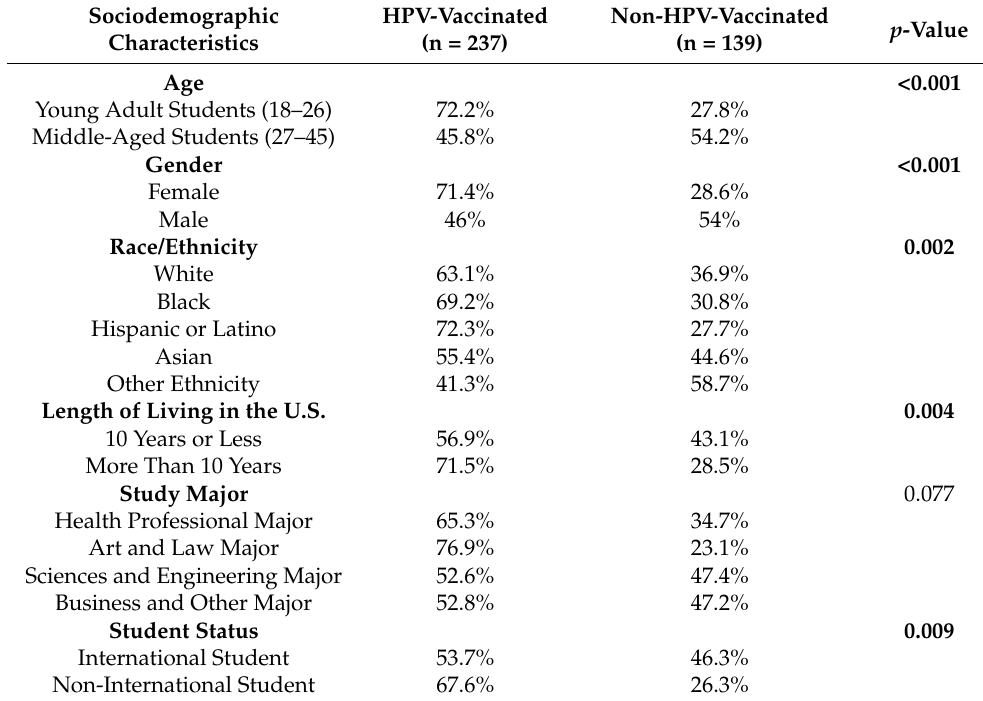
Table 2. HPV vaccination rate across different sociodemographic characteristics of foreign-born